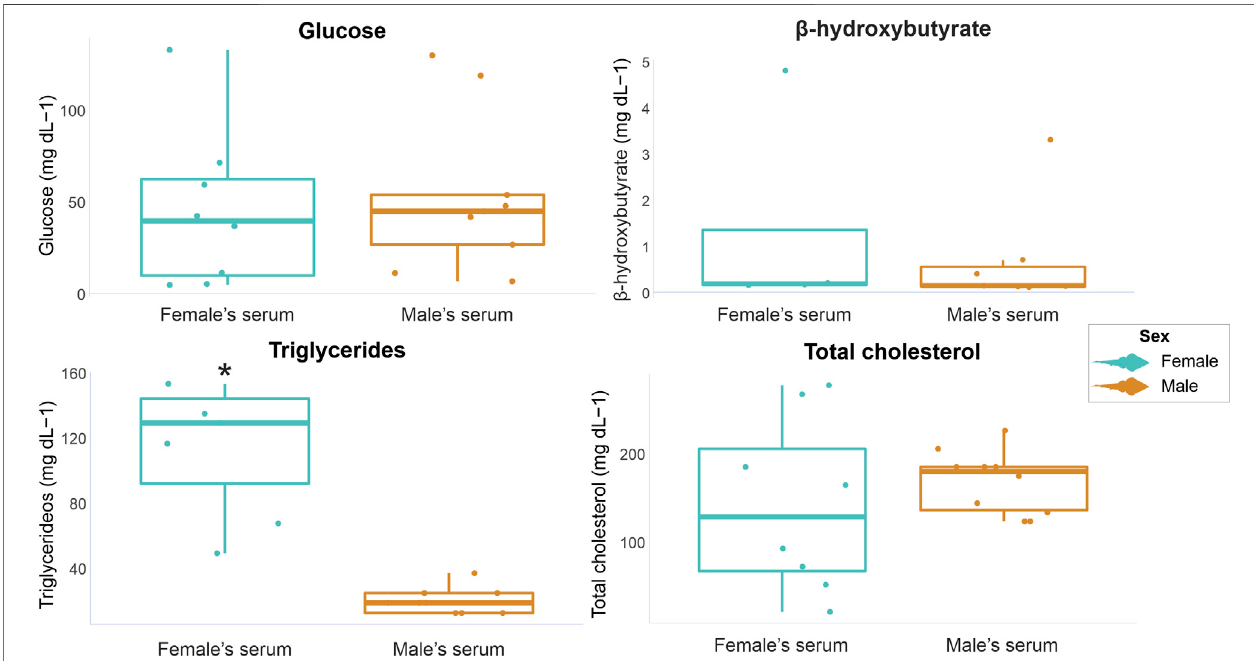
FIGURE 2 | Graphical representation of P. horkelii energetic marker concentrations in the serum of pregnant females (light blue boxplots) and of sexually active males (during the copulation phase) (orange boxplots).